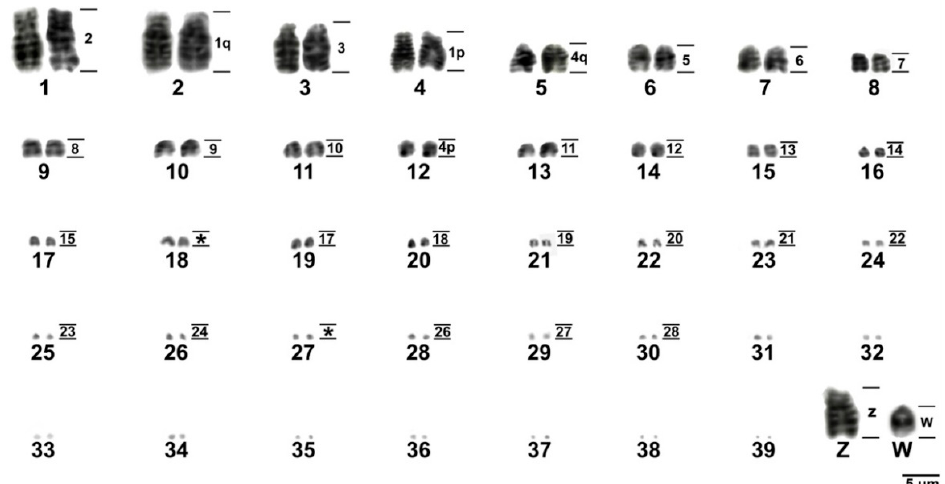
Figure 6. G-banded karyotype of Sicalis flaveola and homologous chromosomal segments with Gallus chromosomes (right). Figure 6. G ‐ banded karyotype of Sicalis flaveola and homologous chromosomal segments with * Asterisks indicate the probable chromosomes corresponding to GGA16 and Gallus chromosomes (right). * Asterisks indicate the probable chromosomes corresponding to GGA16 and GGA25.